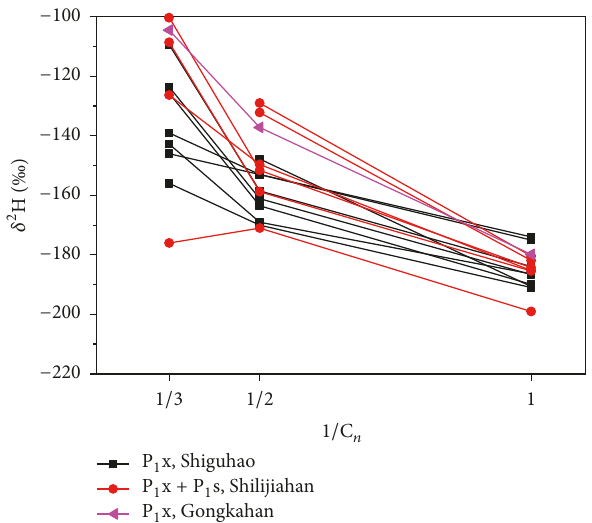
Figure 6: Correlation diagram between C 2 /C 3 and C 2 / i C 4 values of tight gas from the Hangjinqi area (modified after Prinzhofer and Battani [39]).